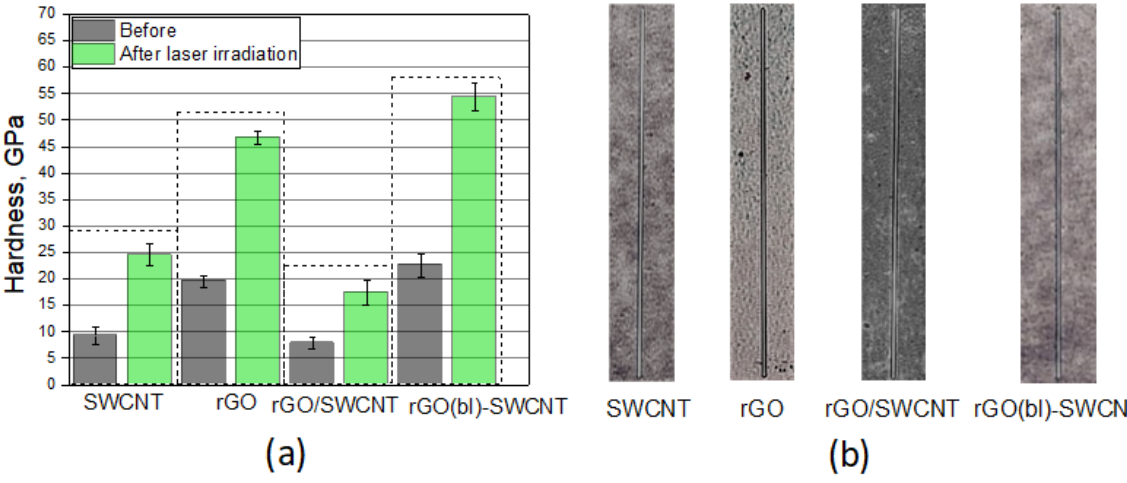
Figure 10. ( a ) Hardness before and after laser exposure and ( b ) Scratches formed on SWCNT, rGO, rGO/SWCNT, and rGO(bl)-SWCNT layers after laser